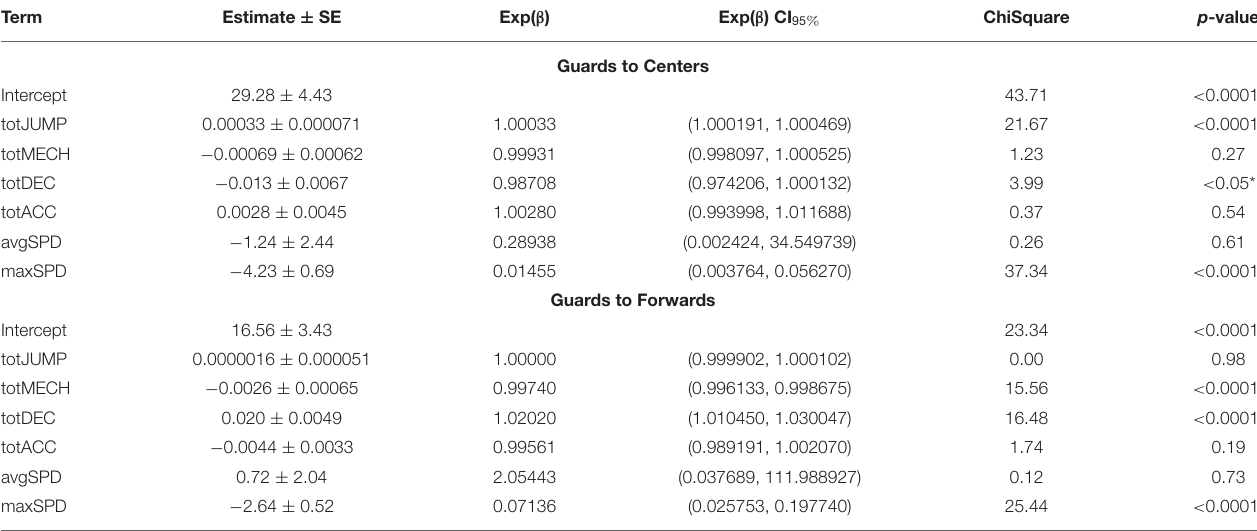
TABLE 1 | Summary parameter estimates from a multinomial logistic regression on external load variables.